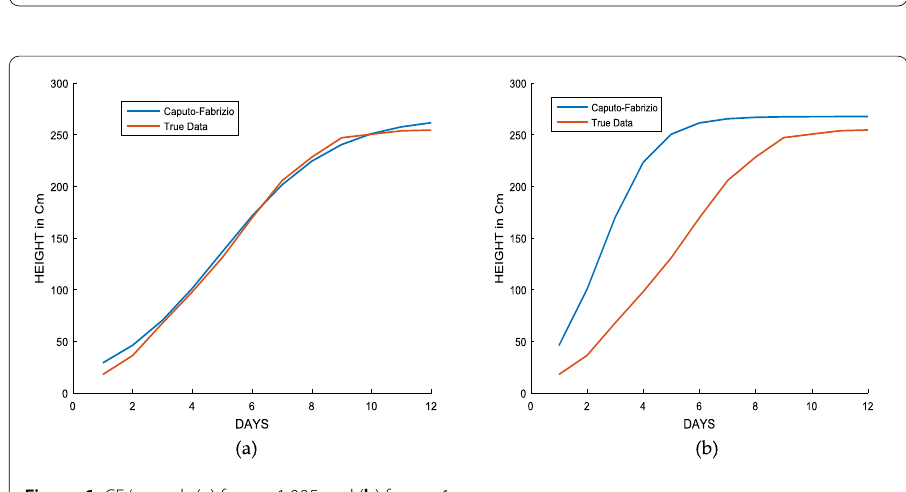
Figure 6 CF ‘s graph ( a ) for q = 1.005 and ( b ) for q =